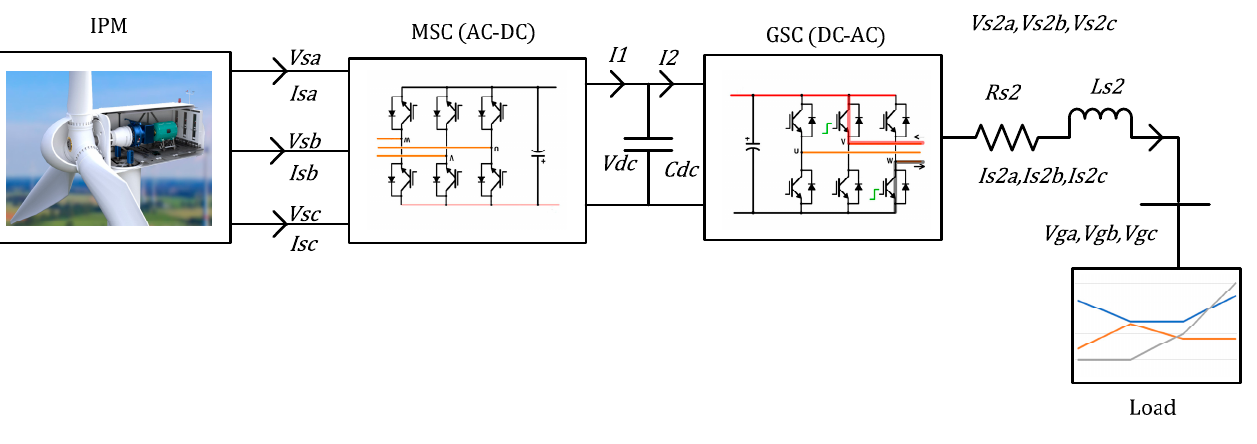
Figure 6. The basic diagram of the IPM wind turbine system.